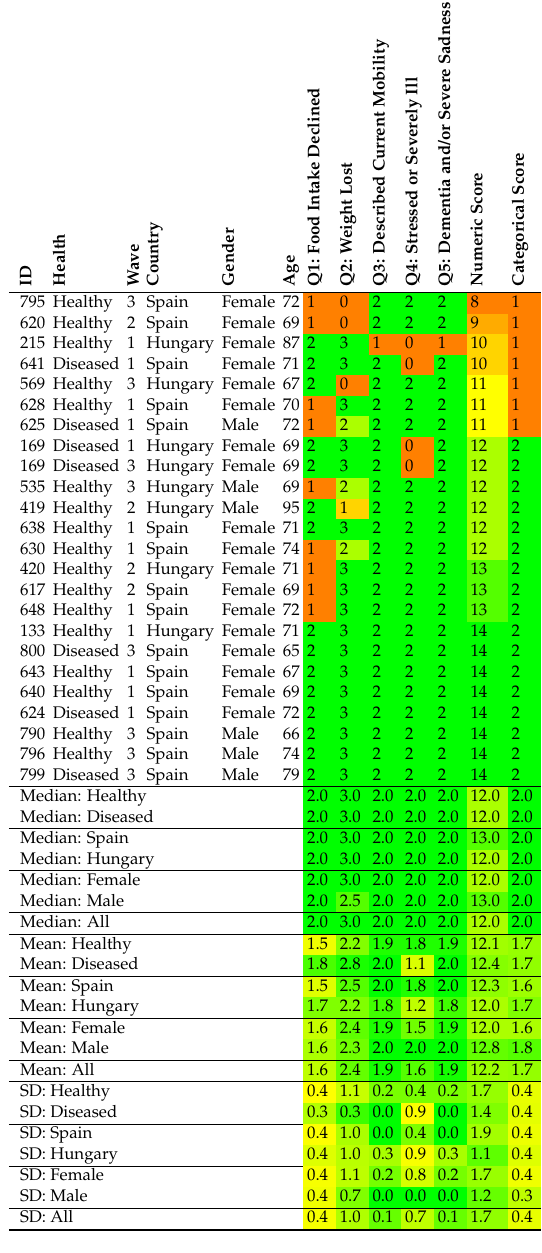
Color coding: from orange (worse outcome relative to others) to yellow, to green (better